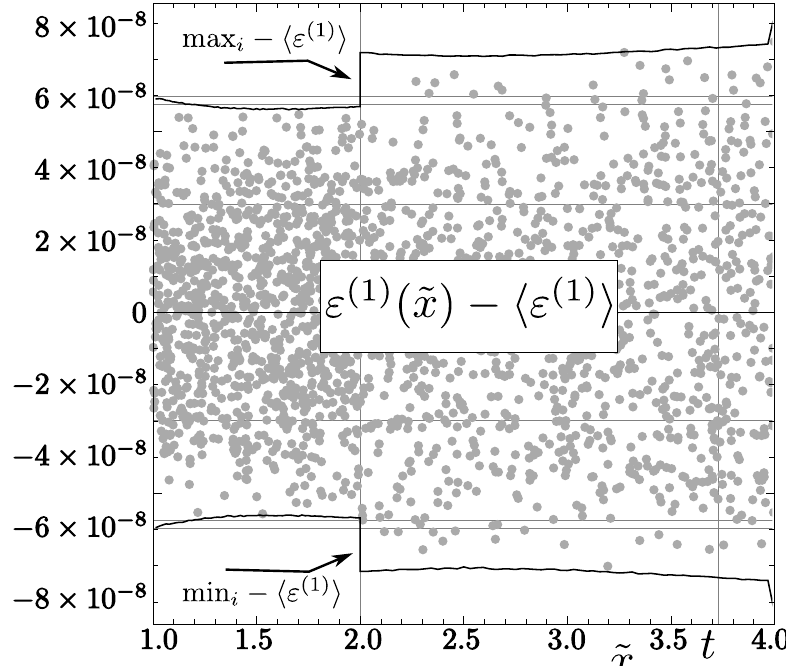
( 1 ) ( ˜ x , t ( 1 ) ) . Its vertical shifts by ± 6 × 10 − 8 are denoted by 2